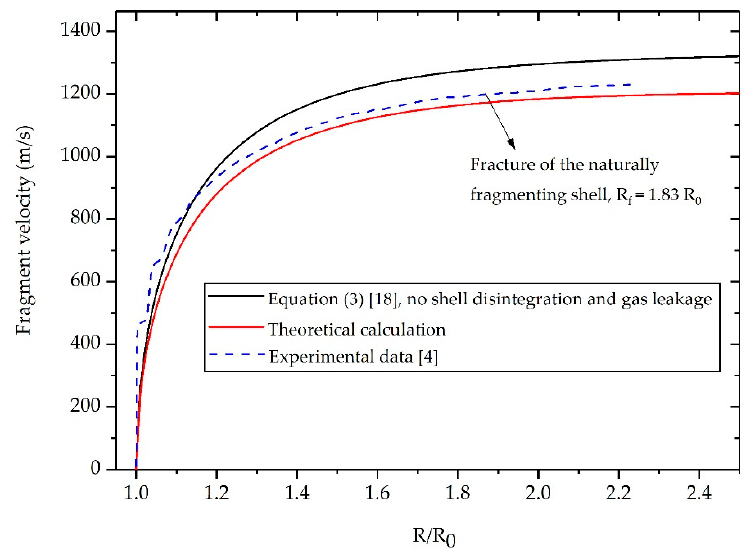
Figure 3. Velocity histories of fragments generated from a naturally fragmenting shell made from AISI 1045 steel.